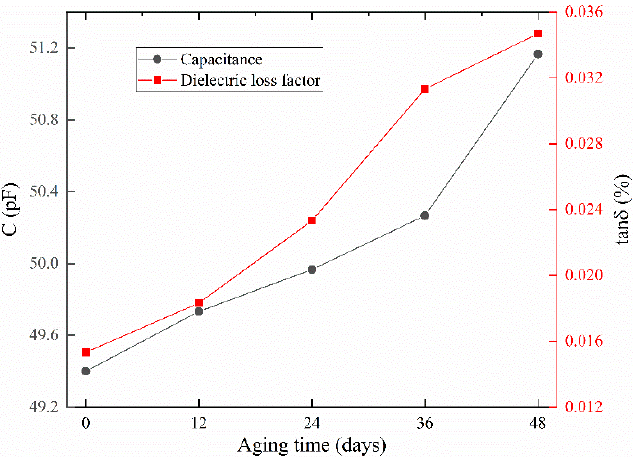
Figure 4. The changes in capacitance and dielectric loss factor of cable sample with aging time.